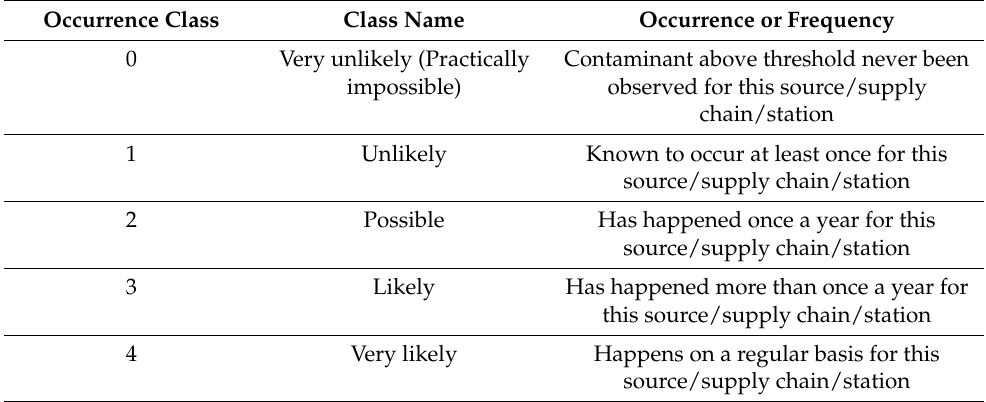
Table 1. Definition of the occurrence or frequency for the probability of contaminant